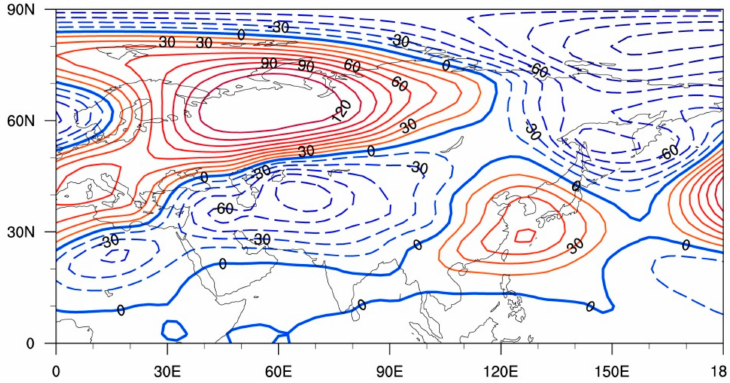
Figure 6. Height anomalies at 500 hPa in January 2008 (based on the National Centers for Environmental Prediction reanalysis dataset; the anomalies are departures from the 1981–2010